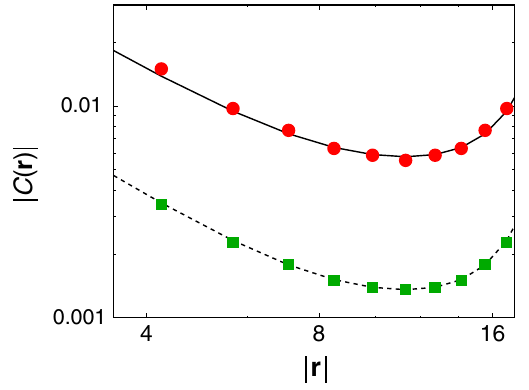
FIG. 7. Real-space spin-spin (red dots) and dimer-dimer (green squares) correlation functions, j C s ð r Þj and j C d for the diagonal direction ( r x ¼ r y ) for 16 × 16 lattice at J 2 ¼ 0 . 5125 in the QSL phase. The solid and dashed lines are proportional to the power-law decay C ð r Þ ∝ ð 1 = j r j z þ η Þ þ P (solid) and 1.62 (dashed), in which we consider the effect of the periodic boundary condition [27]. The values of z þ η are taken from the analysis in Fig. 9(c). The upturn at large j r j is due to the periodicity of the